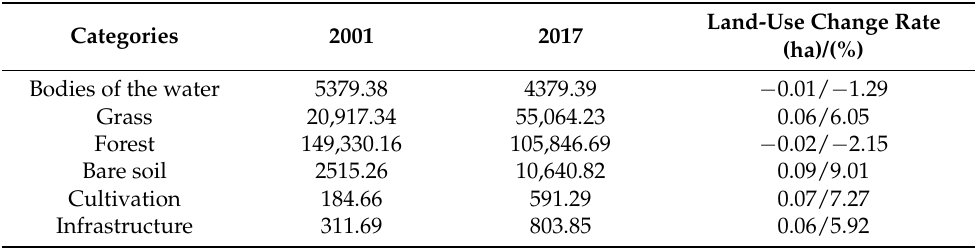
Table 6. Annual rate of change of land cover and use in the ITT Oil Block of the Ecuadorian Amazon region for the period